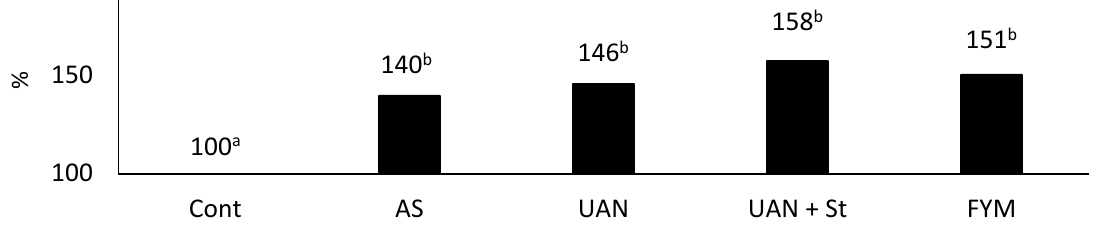
Figure 1. Average maize biomass yield; di ff erent letters behind the values are meaning significant di ff erences among investigated treatments (Tukey test; p < 0.05); number of replications per treatment n = 4.